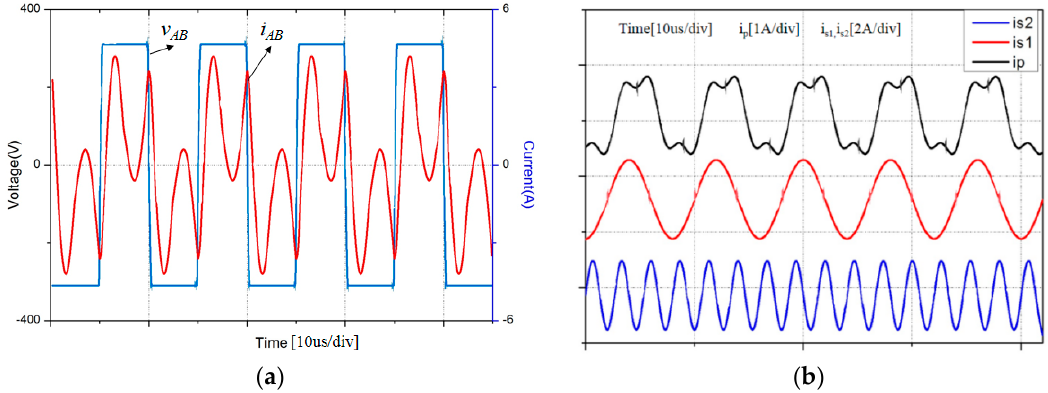
Figure 13. Key waveform of the dual-channel UWPT (under water wireless power transfer) system: ( a ) inverter output voltage and current; ( b ) current in primary and secondary coils.